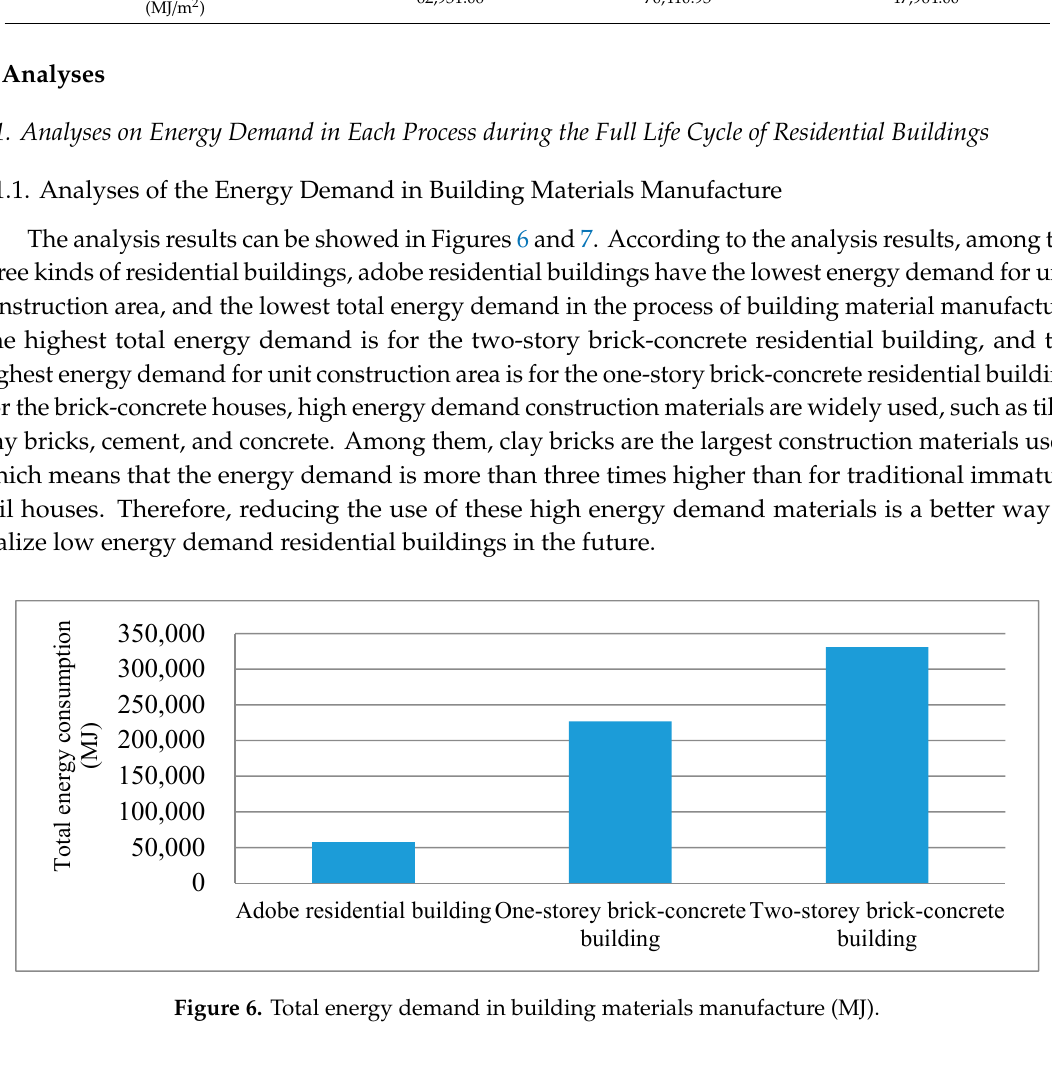
Figure 7. Energy demand of building materials manufacture in unit construction area (MJ). 4.1.2. Analyses of the Energy Demand in Building Erection The calculated results are shown in Figures 8 and 9. According to the calculated results, the building areas and total energy demand are both similar for the adobe residential building and one- story brick-concrete building, while for the two-story brick-concrete building, the building area is twice as large and the total energy demand is also twice as large as the others. Thus, the building area has a direct influence on the calculation of energy demand in this process: the larger the building area, the larger the energy demand for building erection. Beside the building area, the construction method and distance for construction material transportation are also important factors which have an impact on energy demand. The design principle of simple construction methods and the usage of local construction materials can largely reduce energy demand. Figure 8. Energy demand of building erection (MJ).